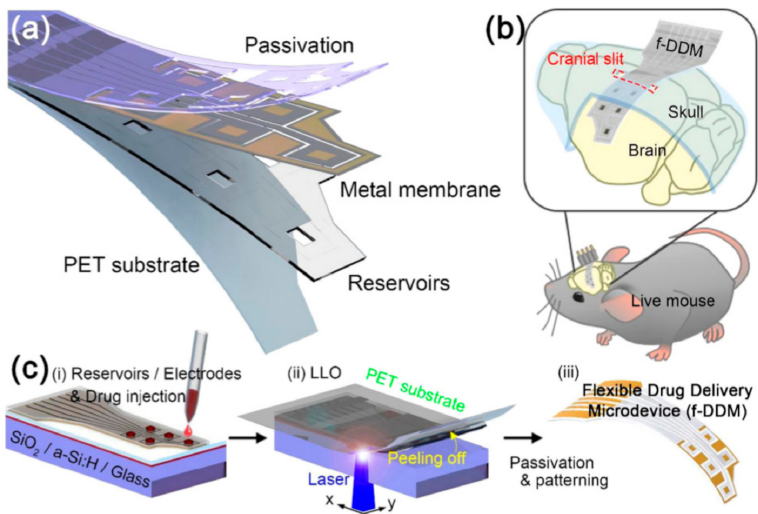
Figure 4. Structure and fabrication process of a flexible drug delivery microdevice [89]. ( a ) Components of the device composed of a positron emission tomography (PET) substrate, epoxy reservoir, metal membrane, and passivation; ( b ) schematic image of the device inserted in the skull of a live mouse; ( c ) fabrication process of the device. (i–iii) Drug injection, transfer process to the flexible PET, and fabricated device after the passivation process. Reproduced with permission from Sung, Nano Energy; published by Elsevier,